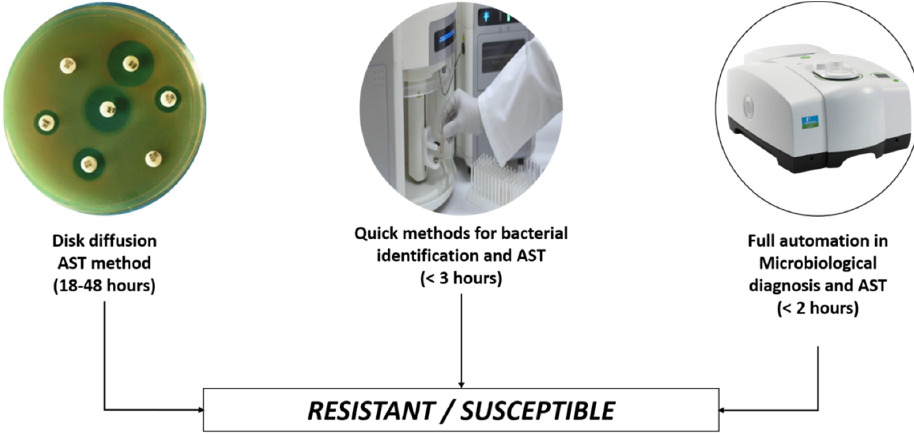
Figure 2. Gold standards method for AST (disc diffusion) v/s automation methods.